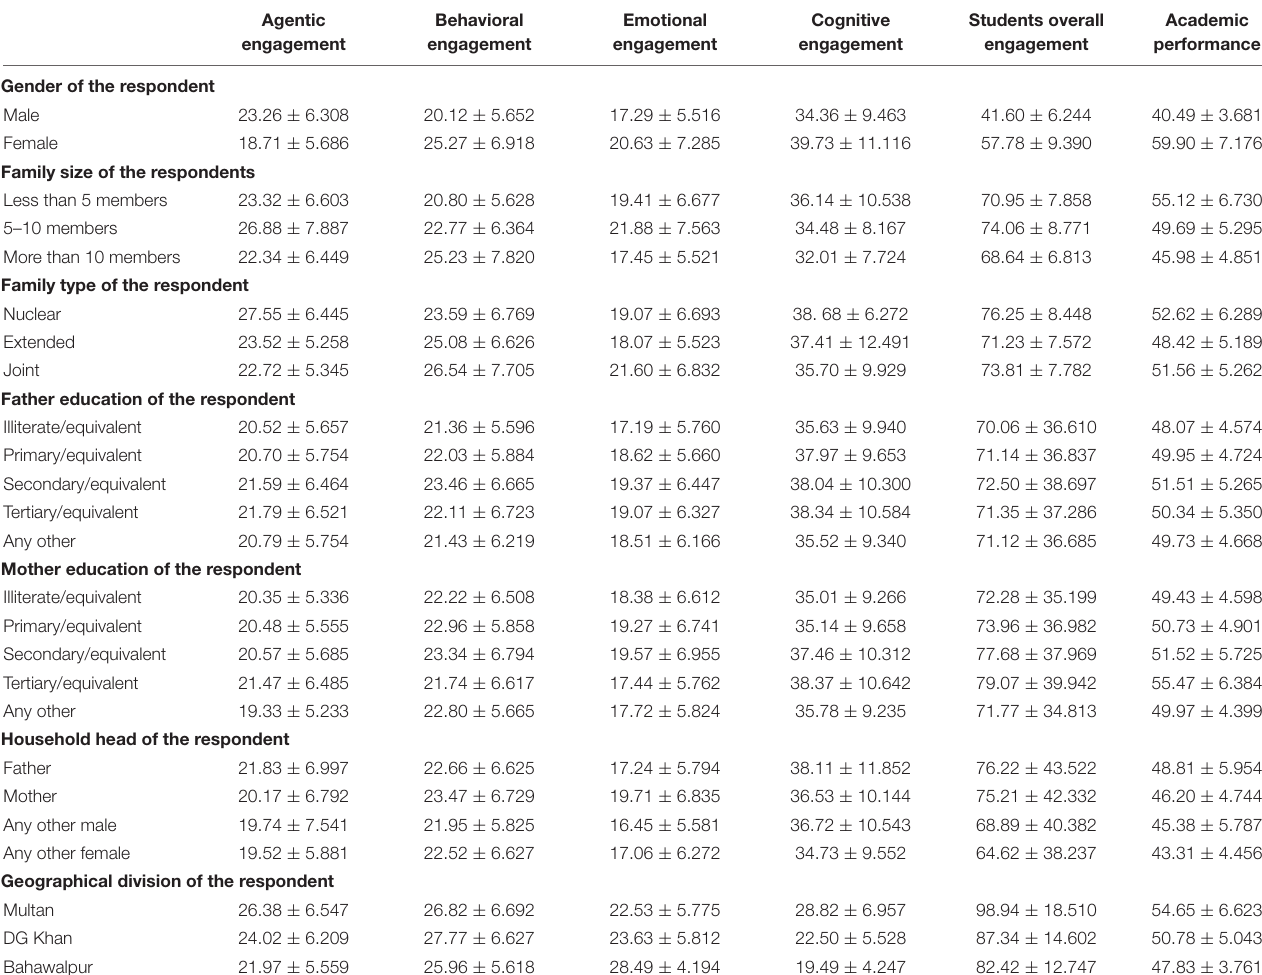
TABLE 4 | Association of socio-demographic variables with students’ engagement and their academic performance ( N = 2,758).